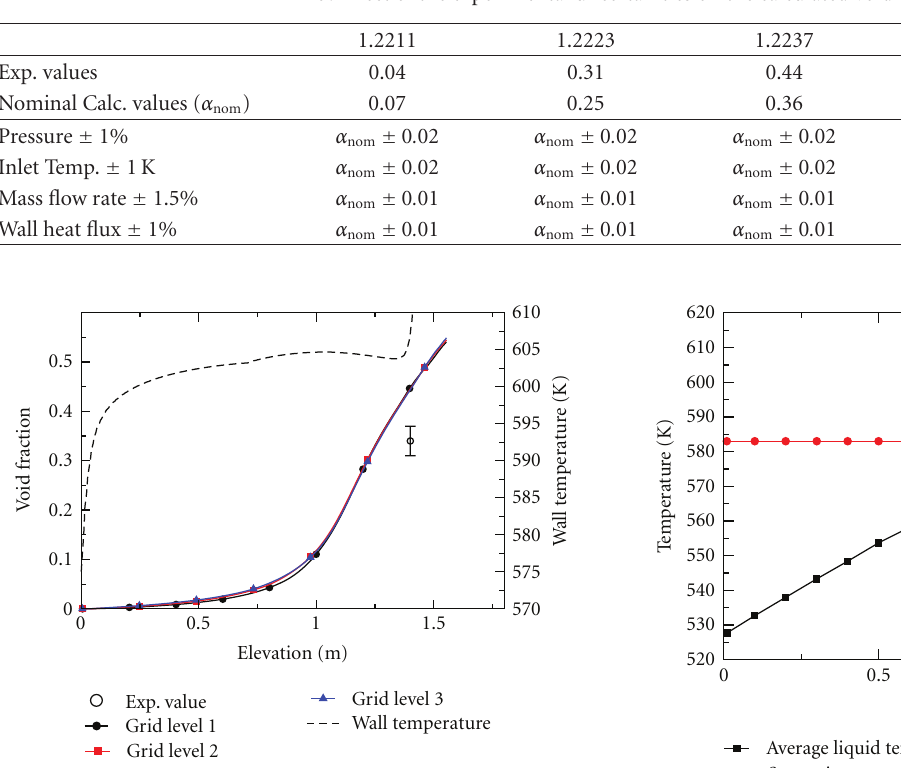
Figure 8: Run 1.4325. Axial evolution of the cross-section averaged void fraction for the 3 grid levels.